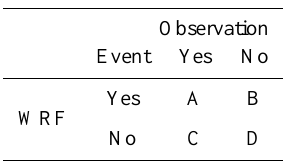
Fig. 3. MODIS snow extent before (22 October 2008) and after (29 October 2008) the Rashmi precipitation event in the MD.